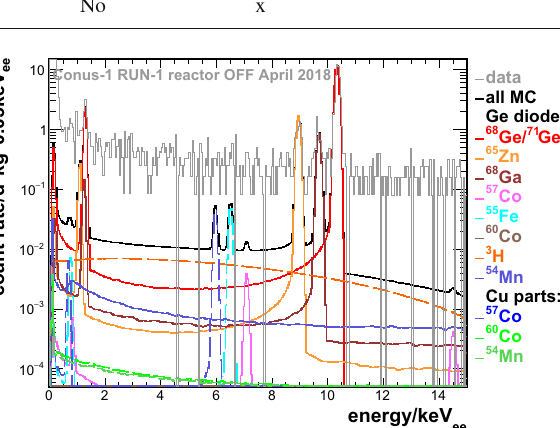
Fig. 12 Contribution of the decay of cosmogenic isotopes evaluated with the MC simulation in comparison to background data of C1 in April 2018 in the lowE range